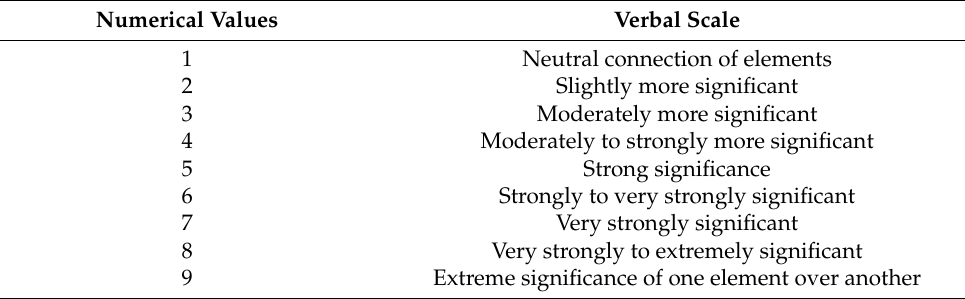
Table 4. Pairwise scale (1–9) of relative weight of criteria in PCMs [54]. Numerical Values